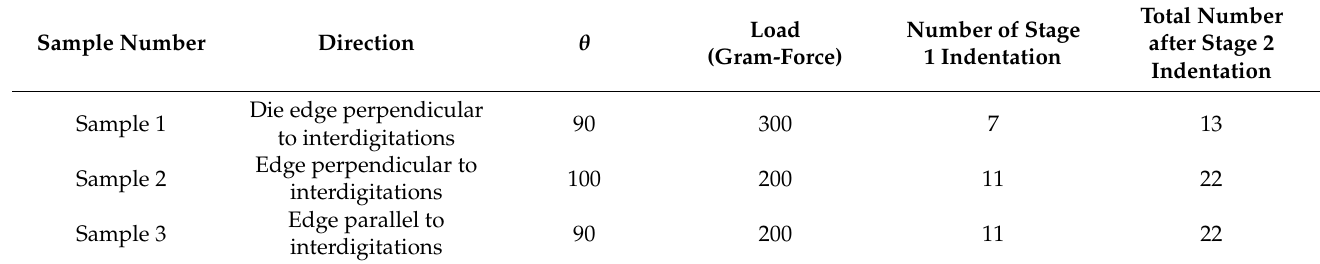
Table 2. Details of sample preparation.